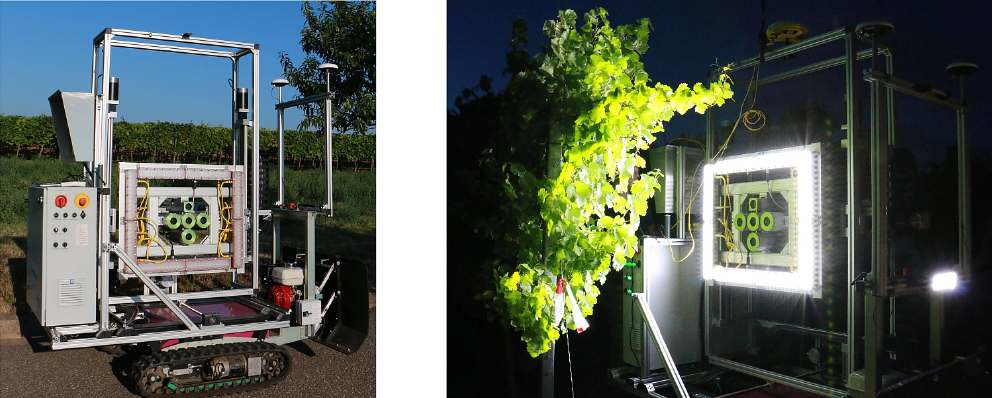
Figure 4. The PHENObot. RTK-GPS is attached at the top. A five camera system is attached on a camera movement frame to adjust the camera-canopy distance and camera height. The RGB camera in the middle of the camera system was used for our purposes. Around the camera system, the lighting unit is situated in a rectangular